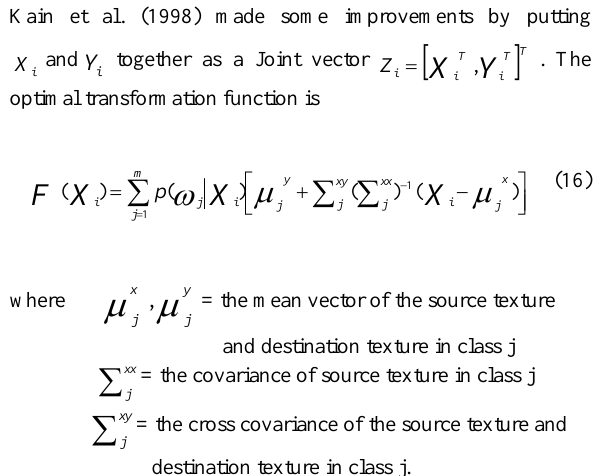
Figure 4. Textures of QuickBird imagery with different orientations(a to f stand the texture images of